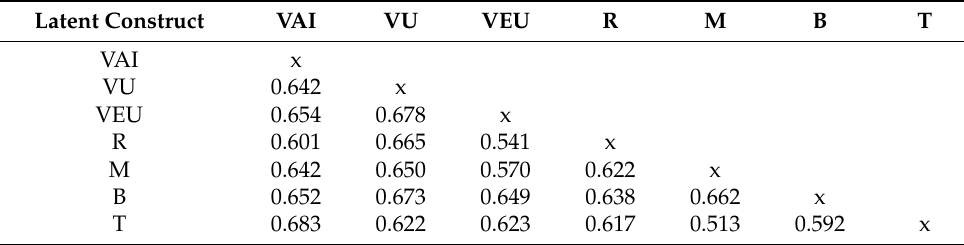
Table 3. Hetero-Trait-Mono-Trait